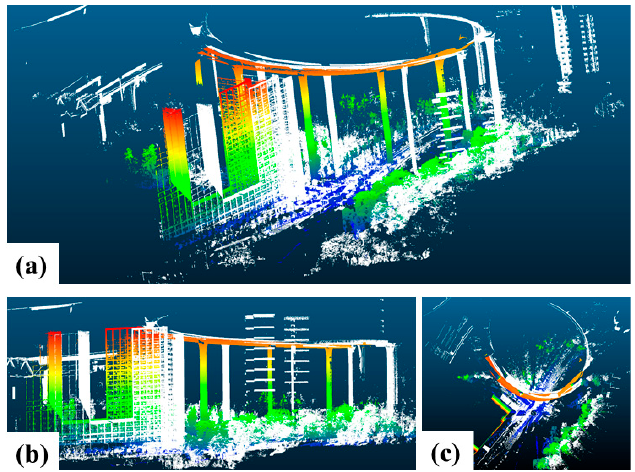
Figure 7. The original point cloud of Sujiaba Bridge. ( a ) free view. ( b ) side view. ( c ) top view. The TLS data of station 1 is shown in white. The colorful points are the TLS data of station 2. The two-point sets with partial overlap.